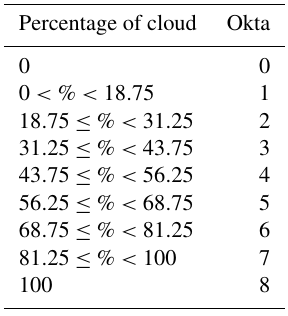
Table 1. Calculation of cloudiness in percentage for corresponding okta